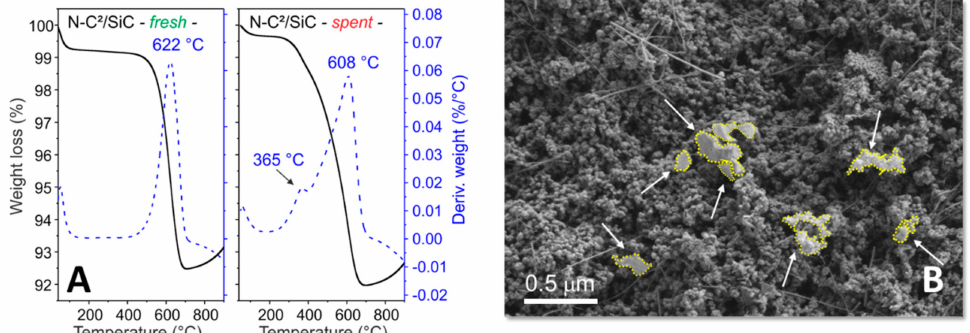
Figure 5. ( A ) TG/DTG profiles of the freshly prepared N-C 2 /SiC (left-side hand) and its exhaust counterpart (right-side hand) at comparison. Weight loss is measured arbitrarily in the 200–700 ◦ C temperature range and it corresponded to: 6.7 wt. loss % on the fresh N-C 2 /SiC and 7.6 wt. loss % on the spent N-C 2 /SiC. Operative conditions: Air, 50 mL/min; heating rate: from 40 to 900 ◦ C at 10 ◦ C/min. ( B ) SEM micrograph of N-C 2 /SiC after its recovery at the end of a long-term catalytic run of 720 h. White arrows indicate residual sulfur deposits marked all around by yellow dashed